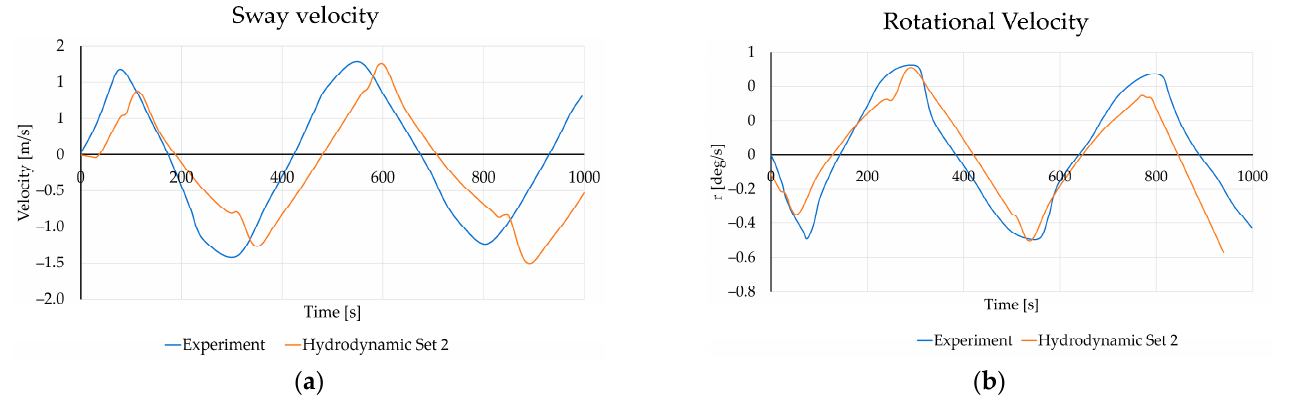
Figure 11. Zigzag 20/20: ( a ) Sway velocity, ( b ) Rotational velocity.